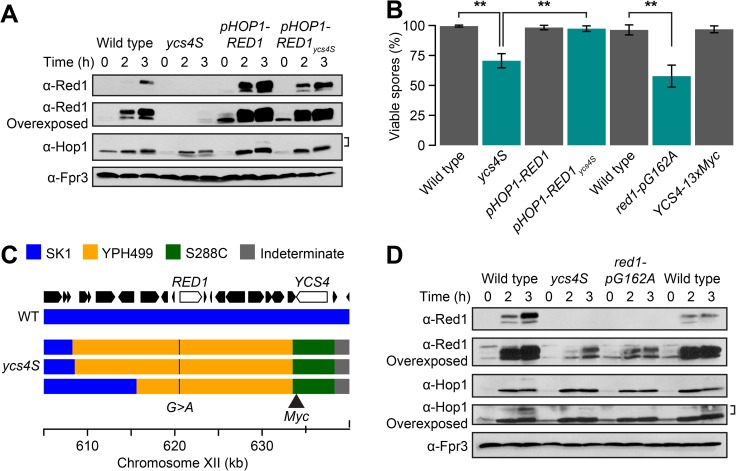
ycs4S mutants have a mutation in the promoter of RED1.(A) Red1 and Hop1 protein levels in wild type (H7797), ycs4S (H7011), pHOP1-RED1 (H8849), and pHOP1-RED1ycs4S (H8850) strains. Phosphorylated Hop1 indicated by bracket. Fpr3 was used as loading control. (B) Spore viability of wild-type, ycs4S, pHOP1-RED1, pHOP1-RED1ycs4S, and YCS4-13xMYC (H9077) strains, as well as red1-pG162A (H9048) mutant strain and a matched control carrying only a marker insertion at position +400 upstream of the RED1 ORF (H9049), n>100. Error bars: S.D. **: p-value: < 0.005, Student t-test. (C) Schematic of the introgressed region in the ycs4S mutant. The genetic background of three separate lines was determined across a 35kb region of chromosome XII, which includes the RED1 and YCS4 genes. This was compared to a wild type SK1 background. Regions were color-coded as SK1 (blue), YPH499 (yellow), S288C (green), and indeterminate (grey). Positions of the 12xMYC tag and the G162A SNP in the promoter of RED1 are indicated. (D) Red1 and Hop1 protein levels in wild type and a ycs4S mutant, as well as a red1-pG162A mutant strain and its matched control. Fpr3 was used as loading control.